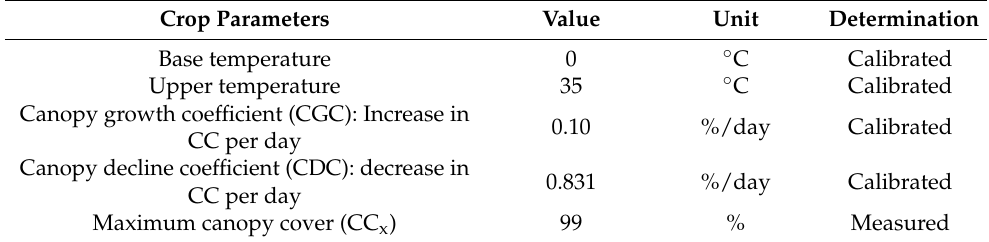
Table 4. Crop and soil parameters used to calibrate AquaCrop